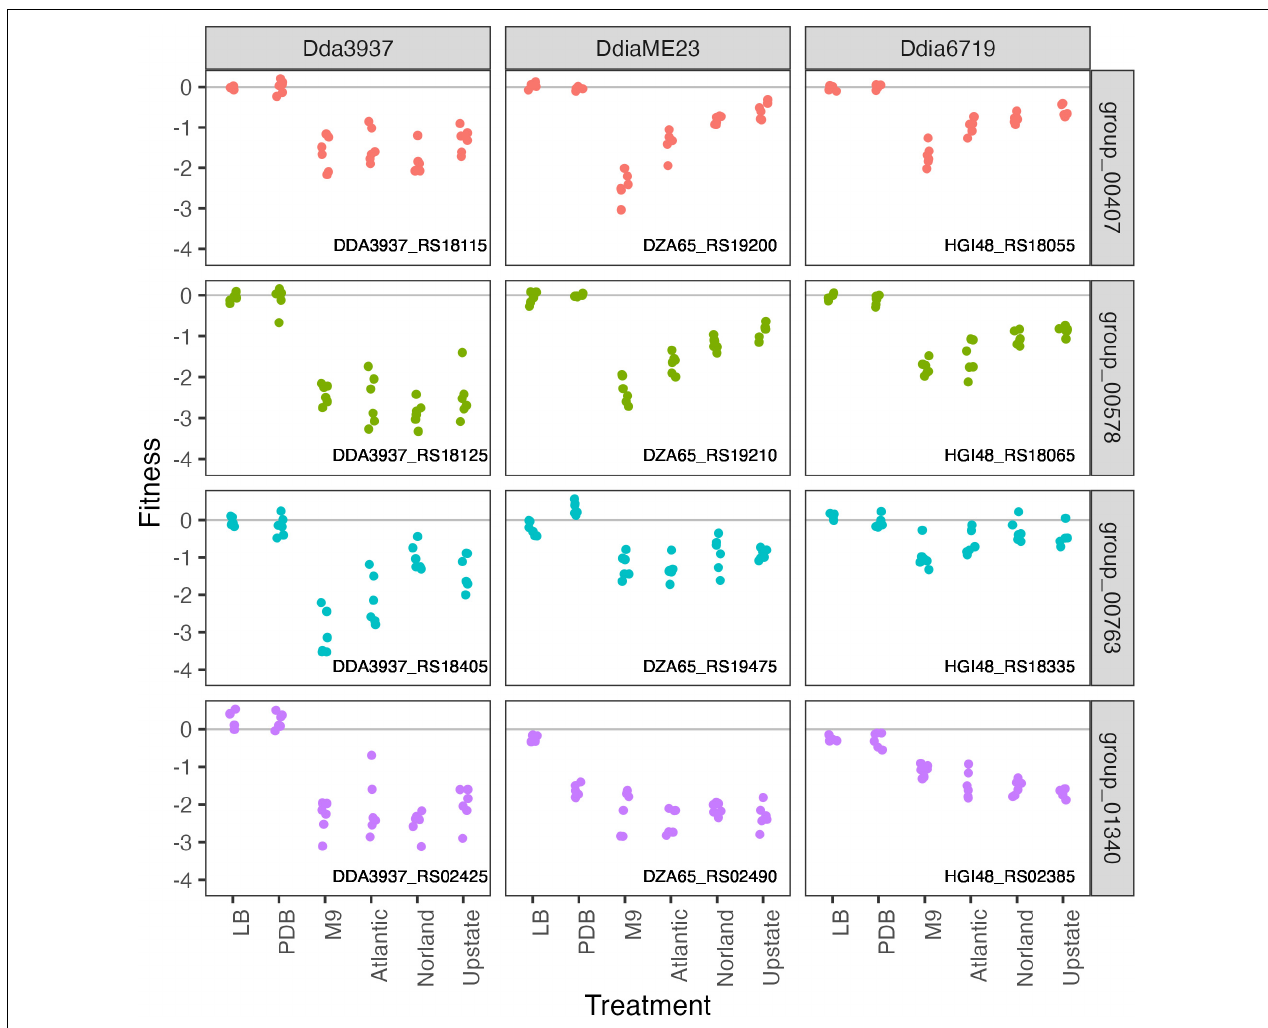
FIGURE 6 | Amino acid biosynthetic genes important in M9 minimal medium as well as growth in potato tubers. Gene fitness values for 2-isopropylmalate synthase LeuA (group 00407), 3-isopropylmalate dehydratase large subunit LeuC (group 00578), threonine synthase ThrC (group 00763), and phosphoserine phosphatase SerB (group